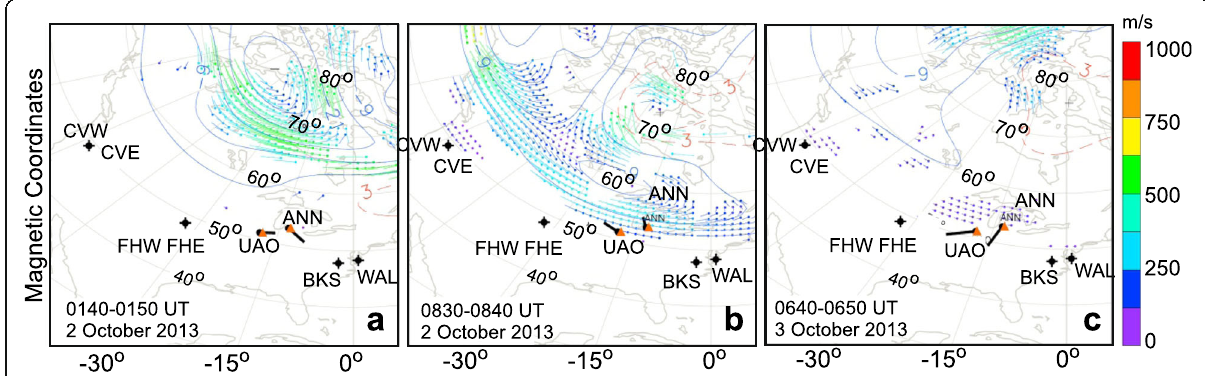
Fig. 32 SuperDARN ionospheric convection maps during the a , b main and c recovery phases of a geomagnetic storm on 2 October 2013, with fitted vectors in locations where measurements were obtained (color coded according to the scale at right) and superposed neutral wind velocity (black vector) measured at the Illinois (UAO) and Michigan (ANN) FPI sites. Locations of the mid-latitude SuperDARN radars operational at this time are identified. Adapted from Figs. 4 and 7 of Joshi et al. (2015)